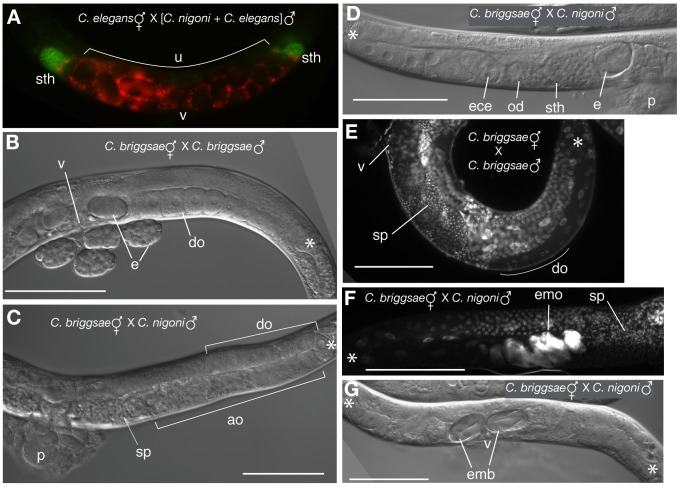
Mechanisms of sterilization by heterospecific males.(A) Shortly after mating, the smaller C. elegans male sperm (red) are displaced from the spermatheca by larger C. nigoni sperm (green) in C. elegans fog-2 “females” doubly mated to vitally dyed males. sth, spermatheca; u, uterus, v, vulva. This panel is a mosaic assembled from multiple overlapping images. (B) C. briggsae adult hermaphrodite after overnight mating with conspecific males. Abundant embryos (e) are restricted to the uterus and reliably laid through the vulva (v). Diakinesis stage oocytes (do) are seen distal to the uterus, but not beyond the bend in the reflexed gonad (asterisk). (C) When mated overnight with C. nigoni males, few embryos are produced despite abundant sperm (sp). Proximal oocytes are abnormal (ao), and diakinesis oocytes are pushed distal to the gonad bend. p, copulatory plug. (D) In hermaphrodites recently inseminated by heterospecific males, the germ line is generally well organized, but ectopic embryos (ece) can be observed distal to the oviduct (od), which is often distended by sperm that have breached it from the spermatheca (sth). Embryos are also seen in the normal uterine position, explaining how some cross progeny are laid [39]. (E) Hoechst DNA staining of conspecifically mated C. briggsae reveals abundant punctate sperm nuclei (sp) that are always restricted to the uterus and spermatheca and multiple diakinesis-stage meiotic nuclei (do). (F) DNA staining of C. briggsae hermaphrodites mated overnight with C. nigoni (similar to B) reveal a zone of endomitotic oocytes (emo) in the proximal region of the ovary abutting a large mass of sperm (sp). (G) In some cases, embryos localized to the uterus (emb) are viable (as judged by their advanced state of development) but not laid through the vulva (v).